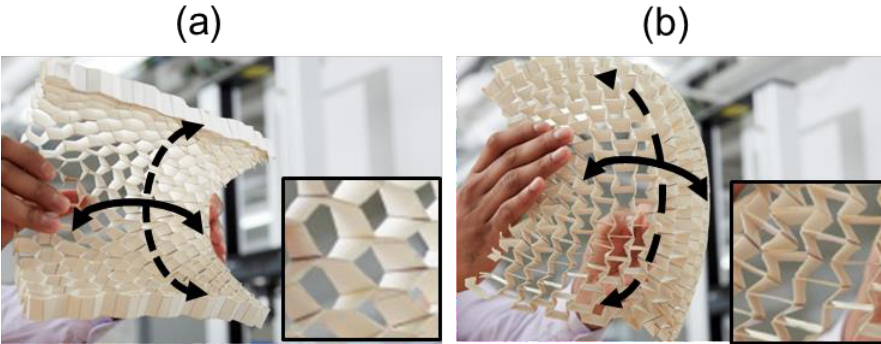
Figure 8. ( a ) Conventional honeycomb showing saddled curvature; ( b ) Re-entrant auxetic honeycomb showing domed curvature. Solid arrows show applied bending and dashed arrows show bending due to Poisson’s ratio. Enlarged pop outs show cell structure .